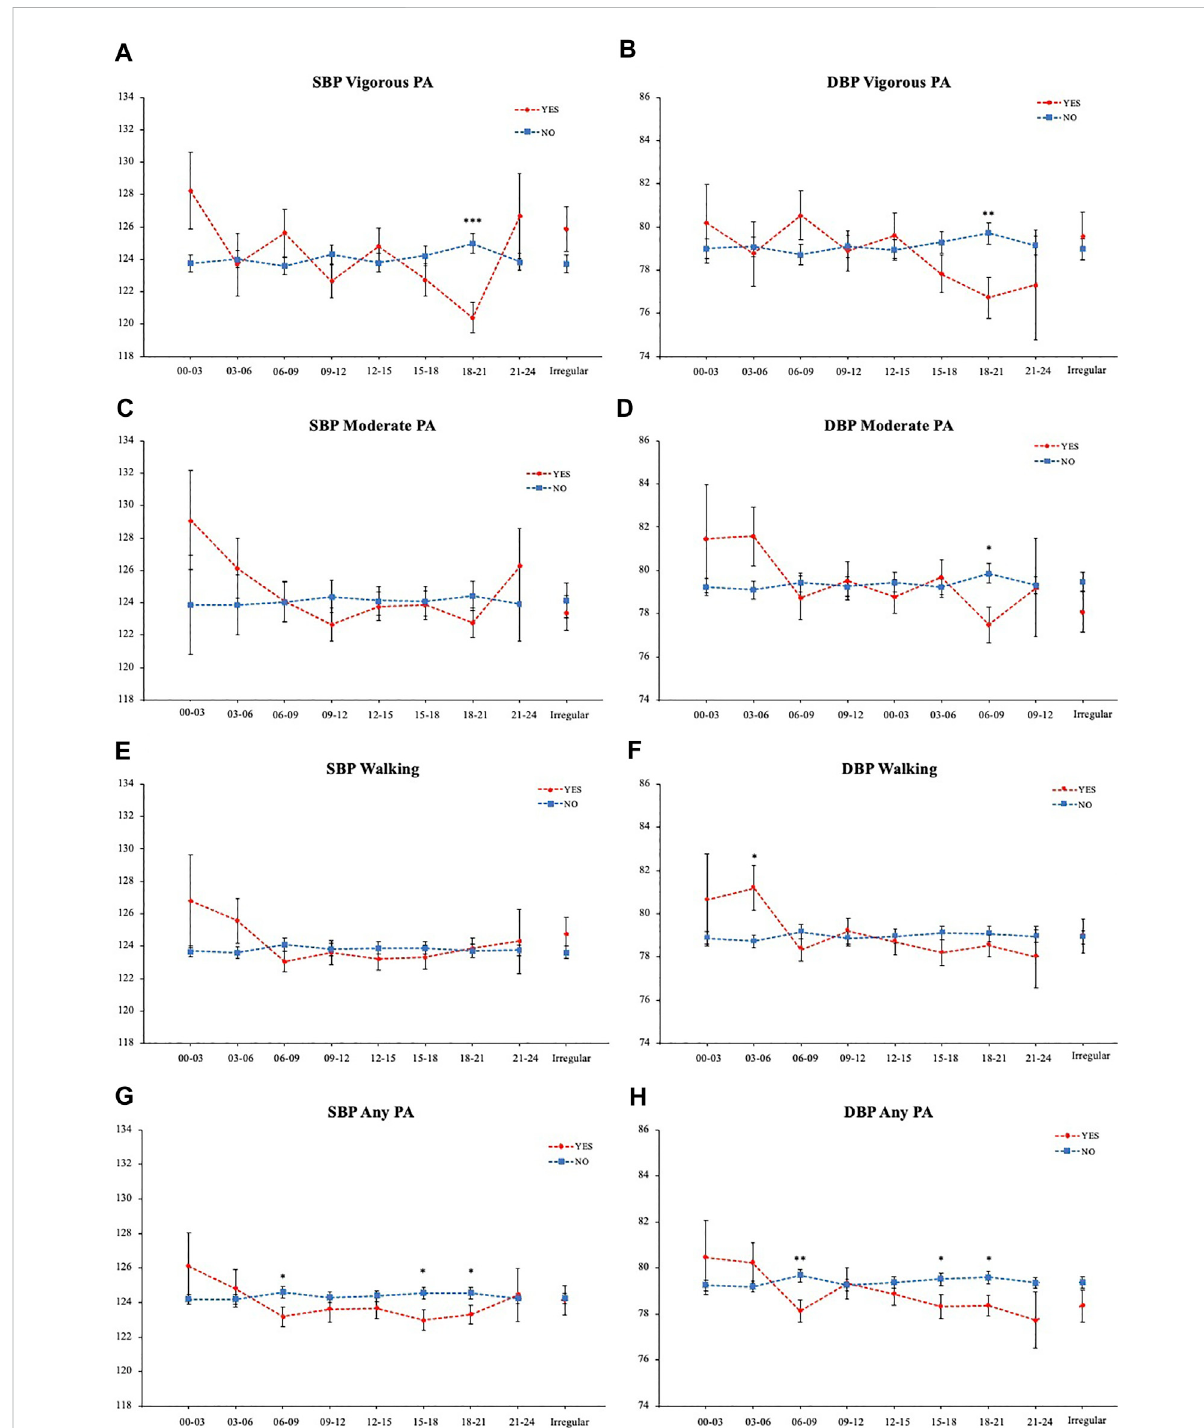
BP comparison of each physical activity timing. (A) Vigorous physical activity SBP (B) Vigorous physical activity DBP (C) Moderate physical activity SBP (D) Moderate physical activity DBP (E) Walking SBP (F) Walking DBP (G) Any physical activity SBP (H) Any physical activity DBP. * p < 0.05, ** p < 0.01, *** p < 0.001 (Student